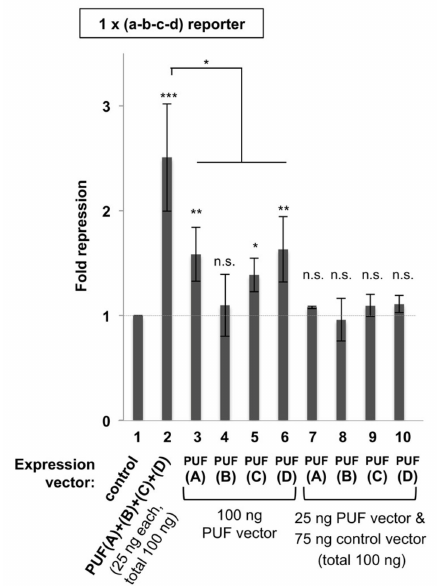
Figure 4. Combination of TTP-PUF (A)–(D) with 1 × (a-b-c-d) reporter e ffi ciently repressed the luciferase reporter activities at the 3 (cid:48) UTR of the luciferase mRNA. NIH3T3 cells were co-transfected with 1 × (a-b-c-d) reporter (1 ng) and 100 ng (total) of the following expression vectors. Lane 1, control vector; lane 2, mixture of TTP-PUF (A), (B), (C), and (D) (25 ng each); lanes 3–6, 100 ng of TTP-PUF (A) (lane 3), (B) (lane 4), (C) (lane 5), (D) (lane 6); lanes 7–10, 75 ng of control vector and 25 ng of TTP-PUF (A) (lane 7), (B) (lane 8), (C) (lane 9), (D) (lane 10). Data are presented as mean ± SD. (***, p < 0.005; **, p < 0.01; *, p < 0.05; n.s. = not